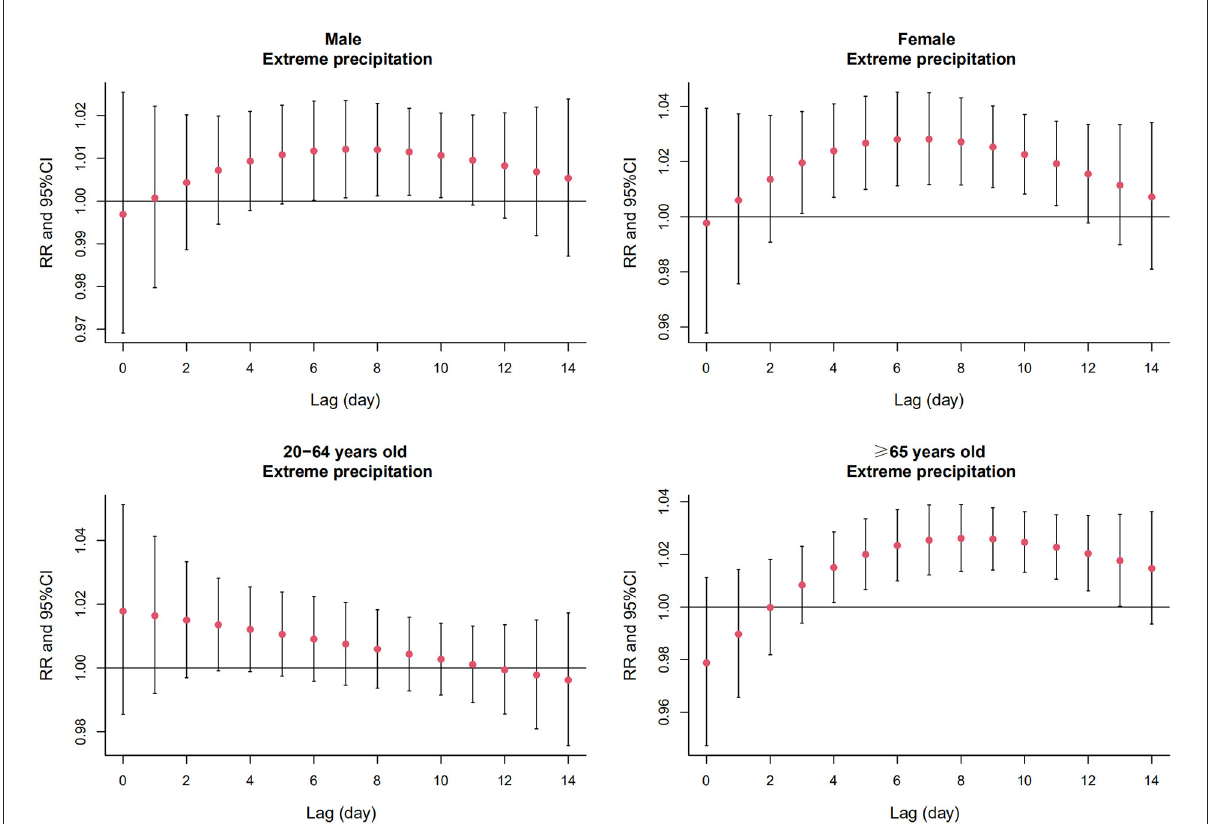
FIGURE4 The relative risk (RR) and 95% confidence interval (CI) of extreme precipitation on AMI hospitalizations of subgroups on different lag days in Beijing, China from 2013 to